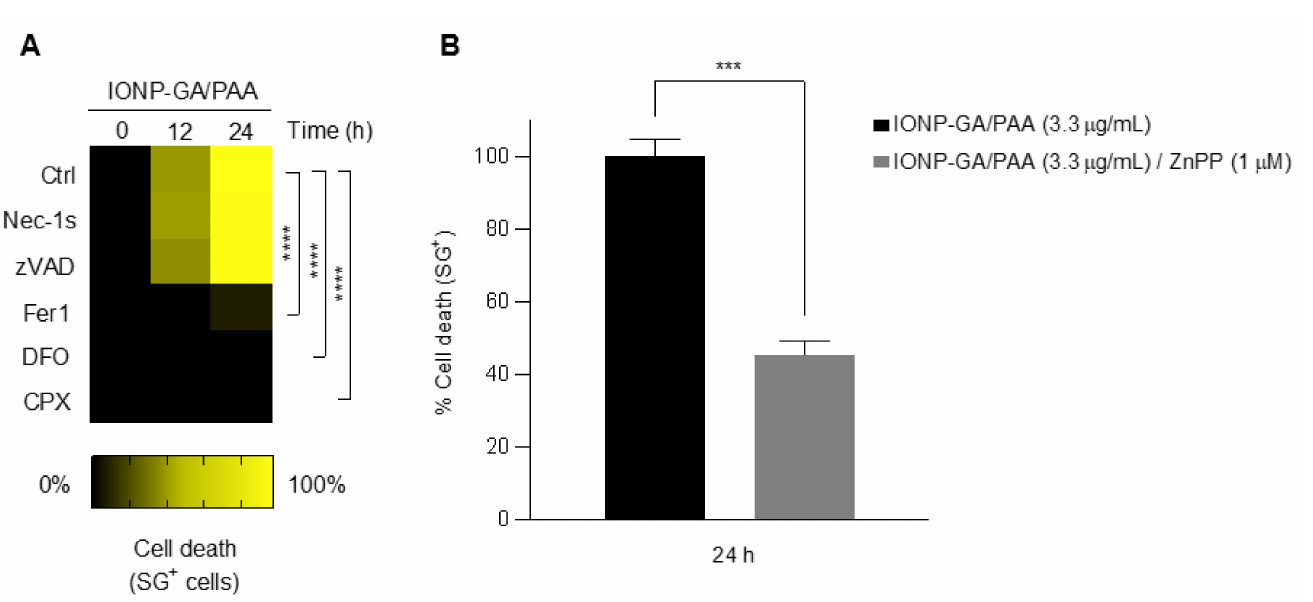
Figure 4. IONP–GA/PAA-induced cell death is blocked by ferroptosis and heme oxygenase-1 inhibitors. ( A ) Heatmap representing cell death sensitivity of HT1080 cells after exposure to 3.3 µ g/mL of IONP–GA/PAA, in the absence or presence of different inhibitors. Necroptosis inhibitor: necrostatin-1 (Nec-1s, 10 µ M). Pan-caspase inhibitor: Z-VAD-FMK, 10 µ M. Ferroptosis inhibitors: the lipophilic free radical trap and lipid peroxidation inhibitor, ferrostatin-1 (Fer1, 1 µ M); and the iron chelators, deferoxamine (DFO, 50 µ M) and ciclopirox olamine (CPX, 5 µ M). ( B )